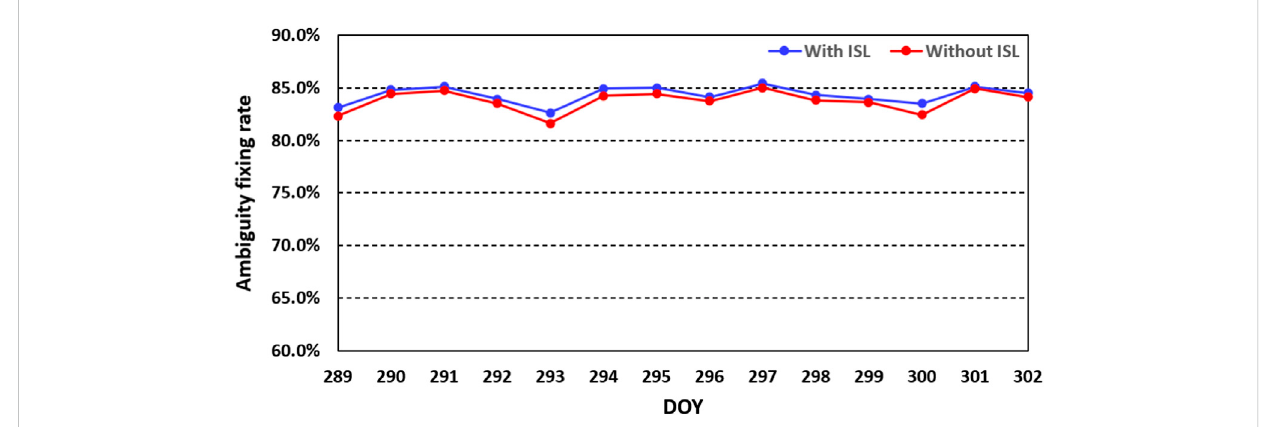
FIGURE 2 Daily fi xing rate of ambiguity resolution with ISL observation (blue line) and without ISL observations (red line) during DOY 289-302, 2020.